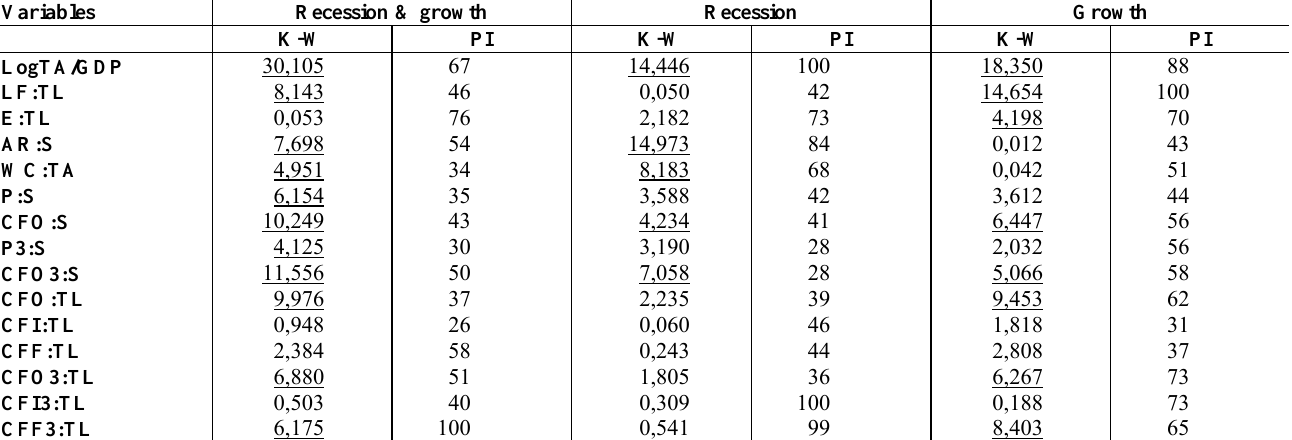
Table 3: Kruskal-Wallis values (K-W) and predictor importance (PI) for classification between failed and non-failed